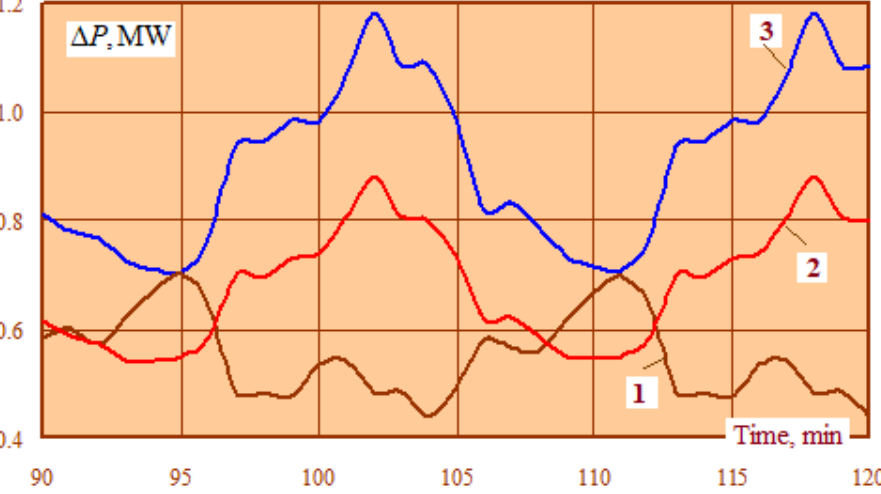
Figure 9. Power losses in the transmission line 1—callout numbers correspond to those in Figure 6.